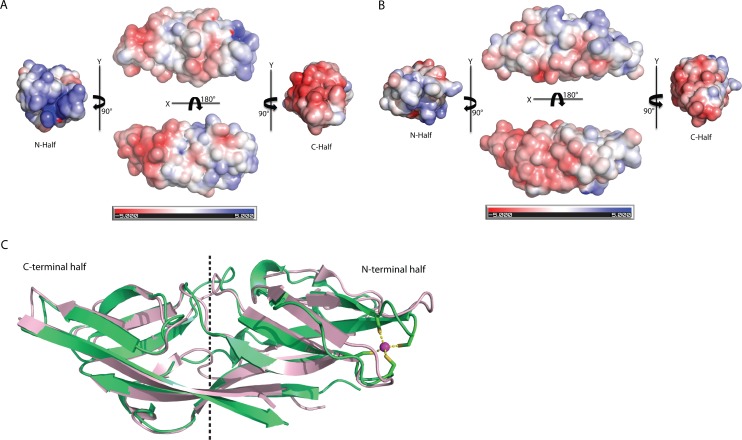
Structure comparison of human C1ORF123 and Plasmodium falciparum homologue.(A) Electrostatic potential surface of C1ORF123. (B) Electrostatic potential surface of MAL13P1.257 from Plasmodium falciparum generated using CCP4MG (McNicholas et al., 2011). (C) Superimposition of human C1ORF123 (green) and its Plasmodium falciparum homologue, MAL13P1.257 protein (pink). The internal two-fold symmetry axis calculated using SymD program is shown as dash line.